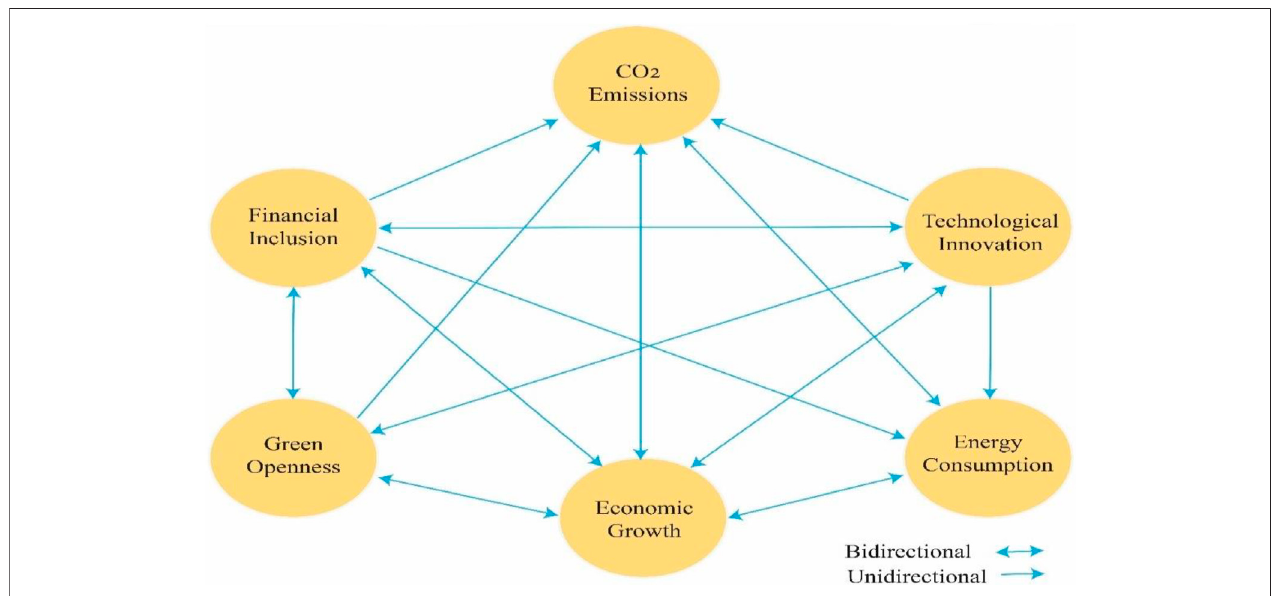
FIGURE 4 | Panel Granger causality